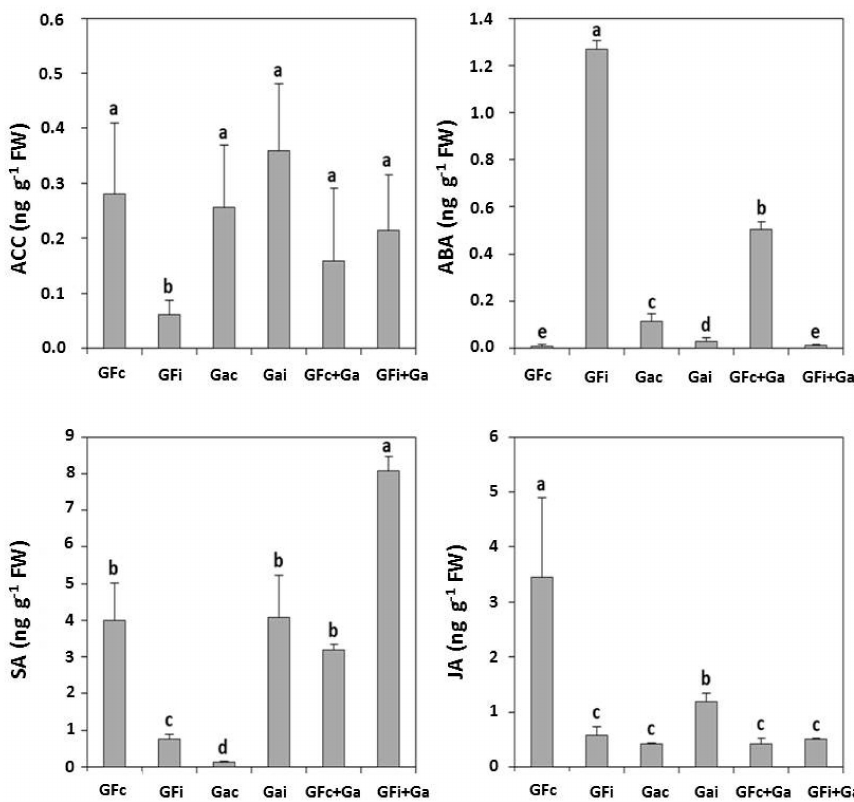
Figure 3. Concentrations (ng · g − 1 fresh weight, FW) of stress-related hormones, including the ethylene precursor 1-aminocyclopropane-1-carboxylic acid (ACC), abscisic acid (ABA), salicylic acid (SA), and jasmonic acid (JA) in control (GFc) and infected (GFi) “GF305” peach showing strong sharka symptoms; control (Gac) and infected (Gai) “Garrigues” almond; and control “GF305” grafted onto “Garrigues” almond (GFc+Ga) and infected “GF305” grafted with “Garrigues”